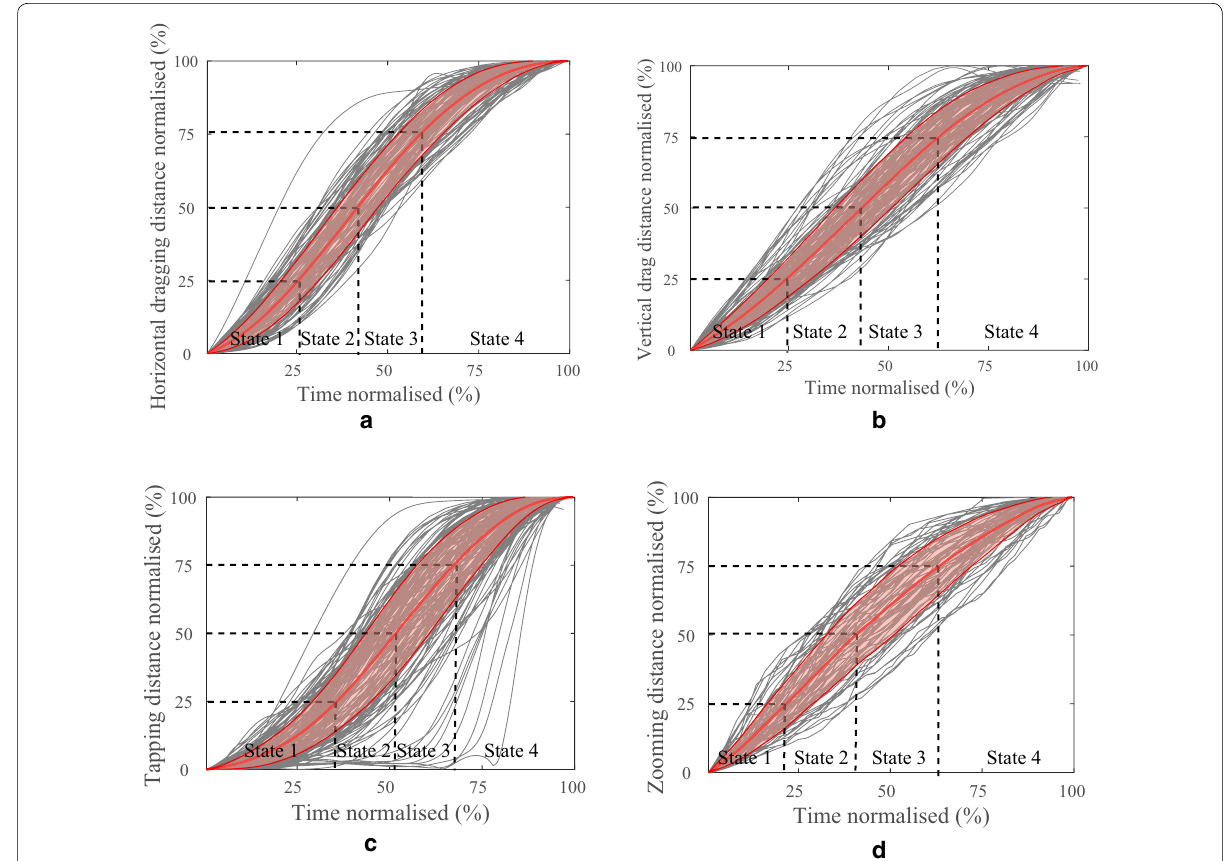
Fig. 3 Ideal motion pattern and primitive motion element definition. Definition of primitive motion element from reference motion pattern for different gestures. a Horizontal drag, b vertical drag, c tapping, d zooming. Here the reference motion pattern is obtained from different subjects and the outlier motion elements are removed based on R 2 value criteria to get the mean and standard deviation as shown by the shaded region in the figure. Finally, a curve fitting tool is used to define primitive motion elements, mathematically in each